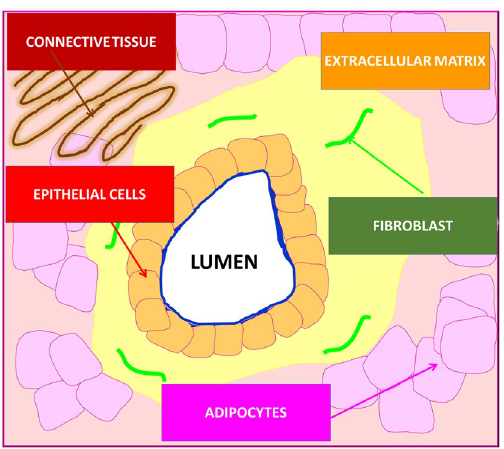
Scheme 1. Schematic representation of the structure of human normal